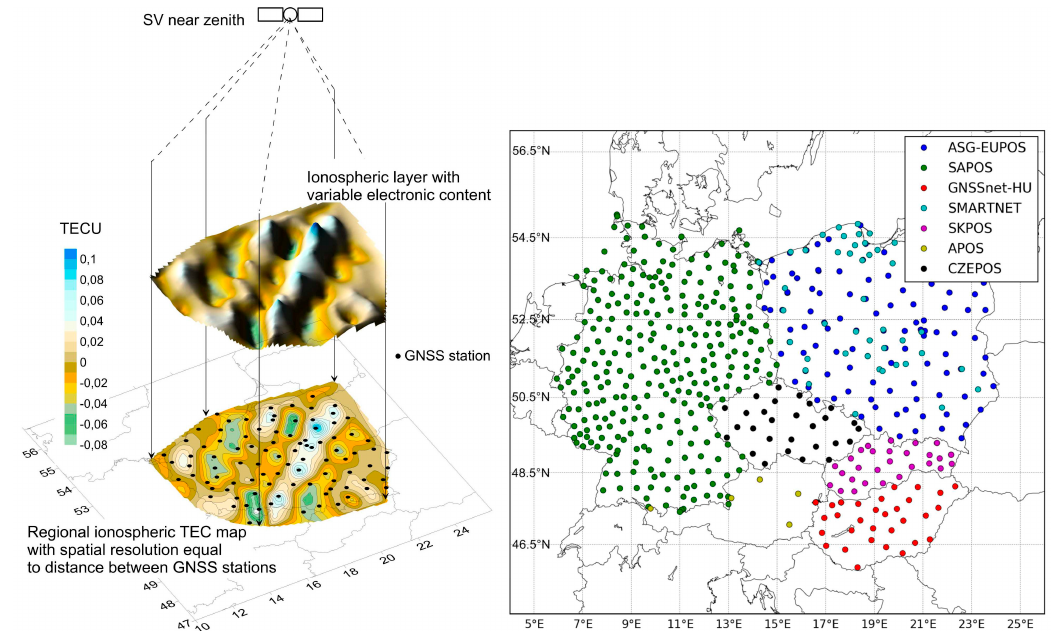
Figure 2. Scheme of the total electron content (TEC) mapping method of orthogonal parallel-beam projection ( left ) and the global positioning system (GPS) reference stations used in this study ( right ). GNSS: global navigation satellite system.